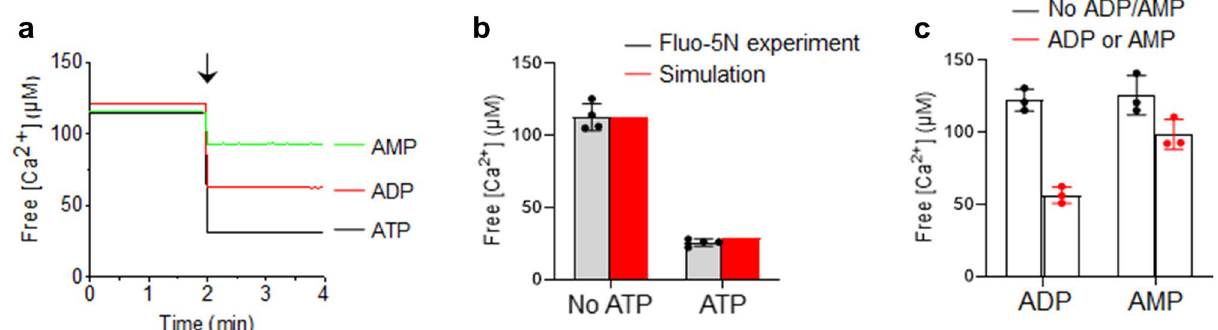
Figure 1. Calibration of free [Ca 2+ ] using Fluo-5N and simulation in the presence of ATP. ( a ) Free [Ca 2+ ] calibration in the presence of ATP, ADP, or AMP using Fluo-5N, a Ca 2+ indicator with K d = 90 μM. 5 mM of ATP, ADP, or AMP was applied (arrow). Representative trace of free [Ca 2+ ] from four independent experiments. ( b ) Comparison of free [Ca 2+ ] in the presence of 5 mM ATP between Fluo-5N and the MaxChelator simulation program, which calculates free [Ca 2+ ] in the presence of ATP and Mg 2+ . ( c ) ADP and AMP chelate free [Ca 2+ ], but the Ca 2+ -chelating efficiency is less than that of ATP. Data in ( b , c ) are mean ± SD from three to four independent experiments (n =